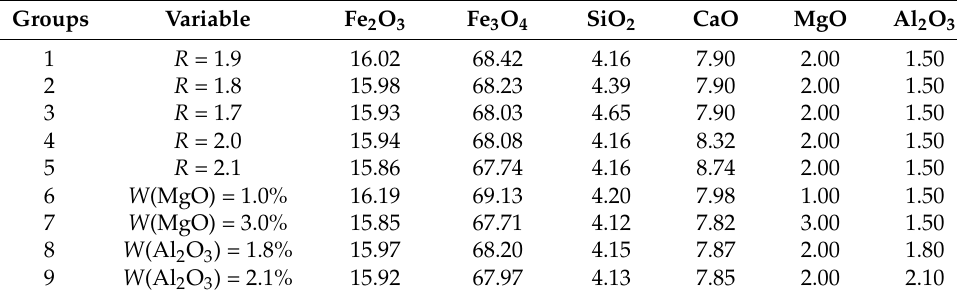
Table 1. Experimental ore blending scheme (mass percent,